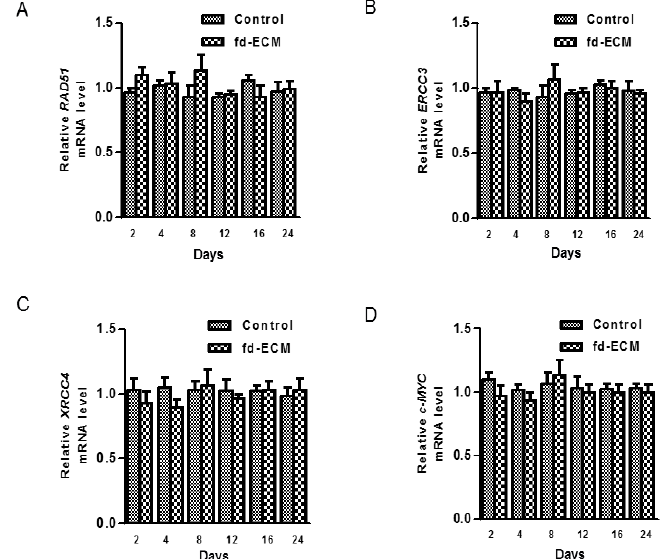
Figure 10. Fd-ECM does not affect transformation markers’ gene expression. ( A ) Ad-MSCs were cultured on plastic and on an fd-ECM for the indicated periods, harvested, and total RNA extracted. RT-qPCR was performed to evaluate RAD51 mRNA levels; ( B ) ERCC3 mRNA levels; and ( C ) XRCC4 mRNA levels; and ( D ) c-MYC mRNA levels.